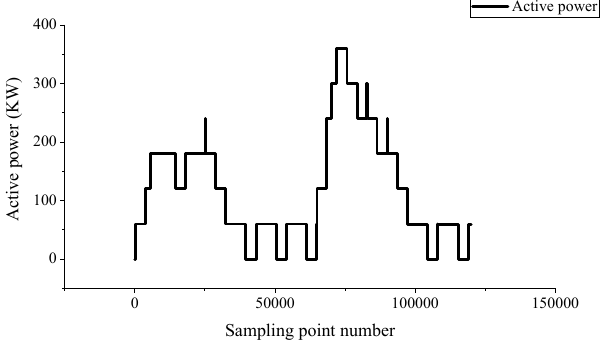
Figure 5. Power–time curve of newly added random load in electric vehicle charging station.